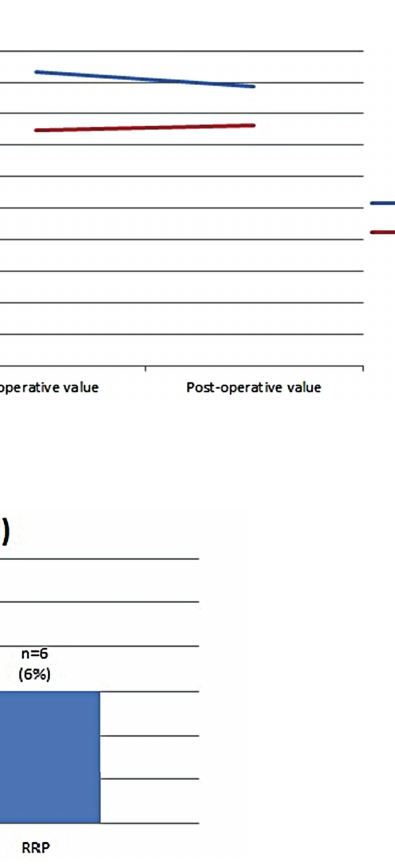
Figure 1 - changes in eGFR and creatinine in both groups.